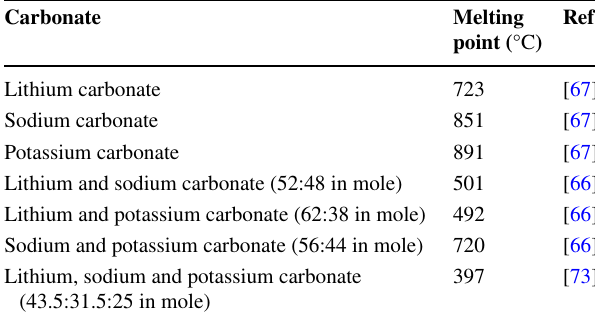
Table 1 Melting point of various